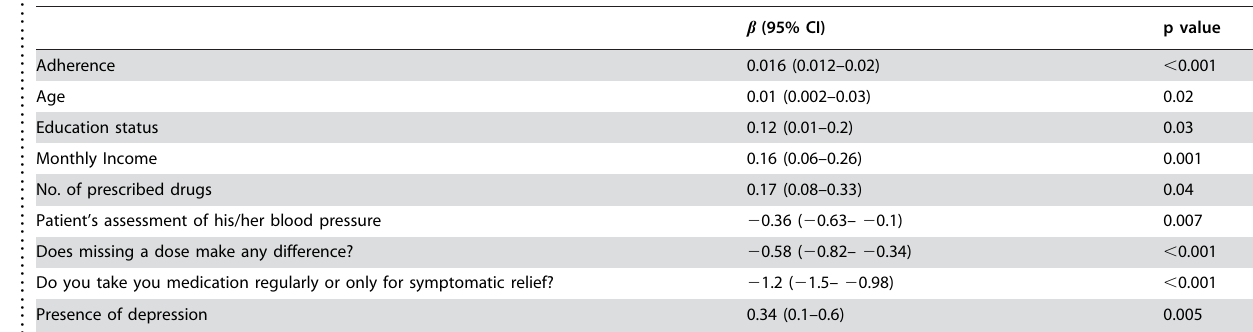
Table 4. Patient factors associated with MMAS .. ... .... ... ... .... ... ... .... ... ... .... ... ... .... ... ... .... ... ... .... ... ... .... ... ... .... ... ... .... ... ... .... ... ... .... ... ... .... ... ... .... ... ...